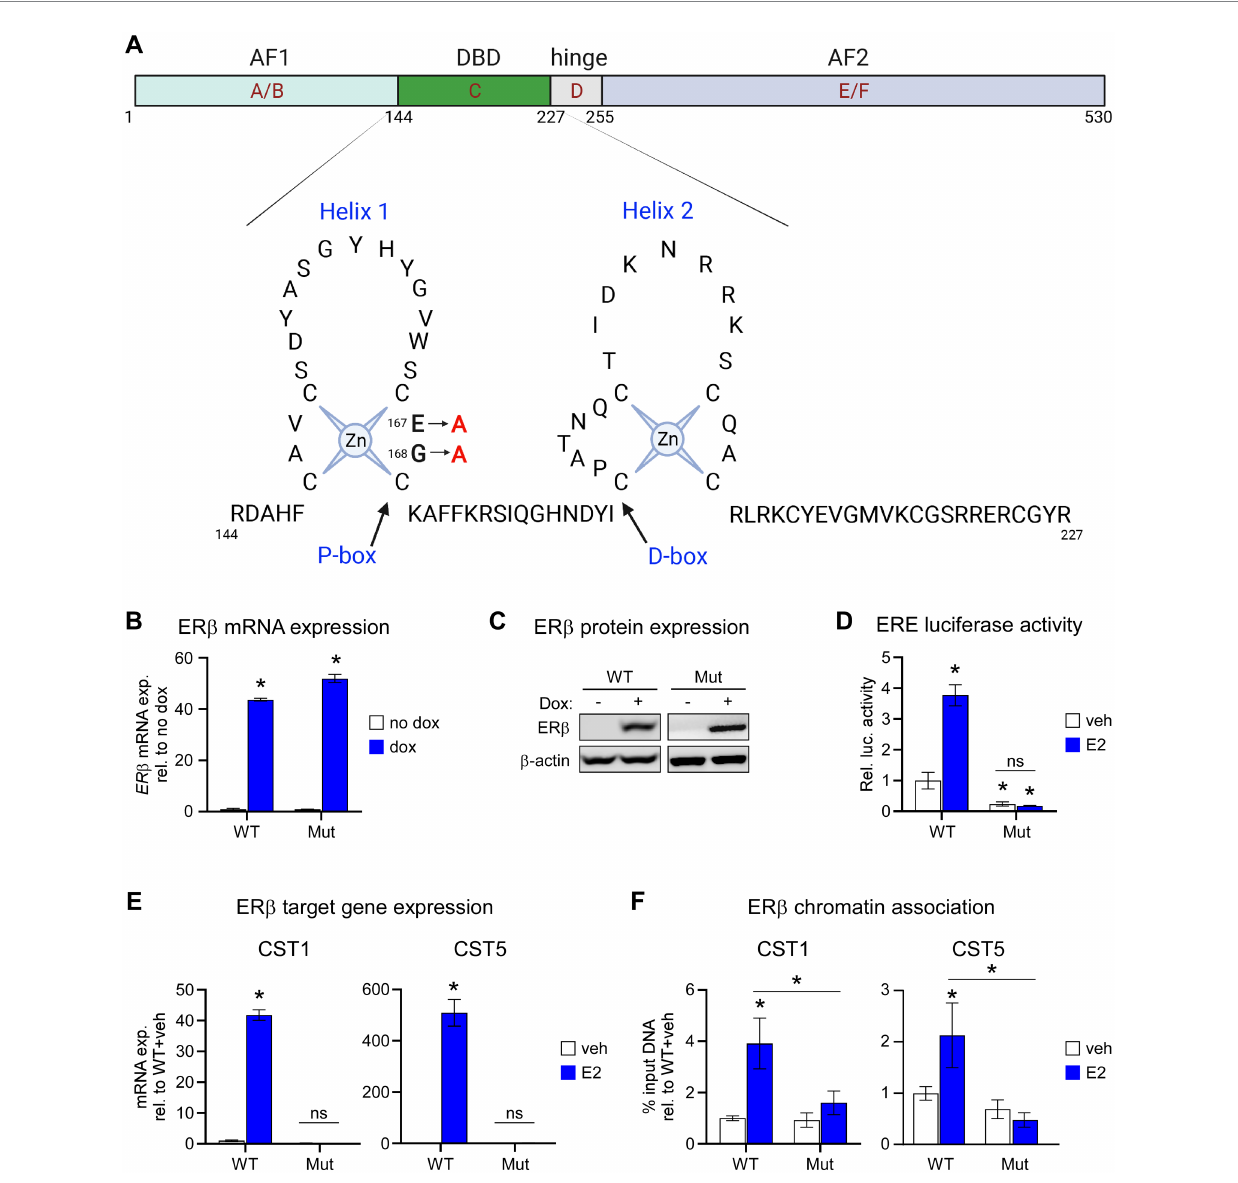
FIGURE 1 Characterization of the ER β DBD-Mut cell line. (A) Schematic depicting two dimensional domain structure of the ER β protein with detailed resolution of amino acids 144–227 consisting of the helix 1 and helix 2 zinc fingers. The two amino acid mutations (amino acids 167 and 168) used to generate the ER β DBD-Mut utilized throughout this manuscript are highlighted. (B) mRNA and (C) protein expression of wild type ER β (WT) and ER β DBD-Mut (Mut) in MDA- MB-231 cell lines following treatment with dox. β -actin shown as protein loading control. (D) Activity of an estrogen response element (ERE) luciferase reporter construct in WT and Mut MDA-MB-231 cells following veh or E2 treatment. (E) mRNA expression levels of CST1 and CST (known ER β target genes) in WT and Mut MDA-MB-231 cells following veh or E2 treatment. (F) ChIP-PCR for ER β at known ER β binding sites located in the promoter of CST1 and CST5 in WT and Mut MDA-MB-231 cells following veh or E2 treatment. Graphs depict % input DNA relative to WT + veh. For all analyses, data is normalized to WT + veh levels and * indicates p < 0.05 relative to either no dox/veh treatment or between specific treatment conditions as indicated by horizontal lines following assessment by